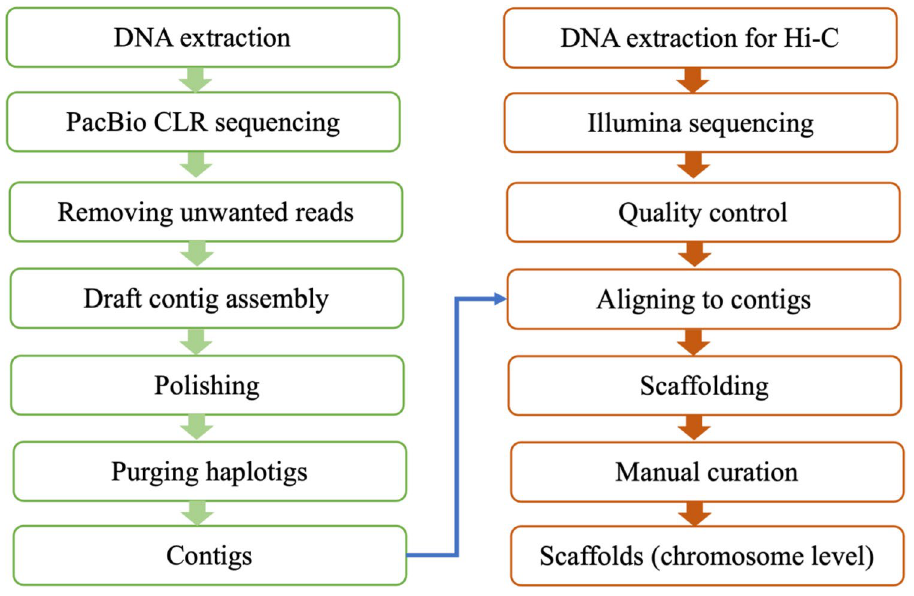
Figure 5. Illustration of the genome assembly